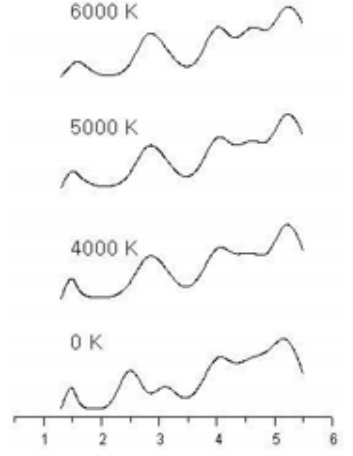
Figure 3. Radial distribution function of the distance ( Å ) between neighboring carbon atoms in the carbon nano-peapod structure at various